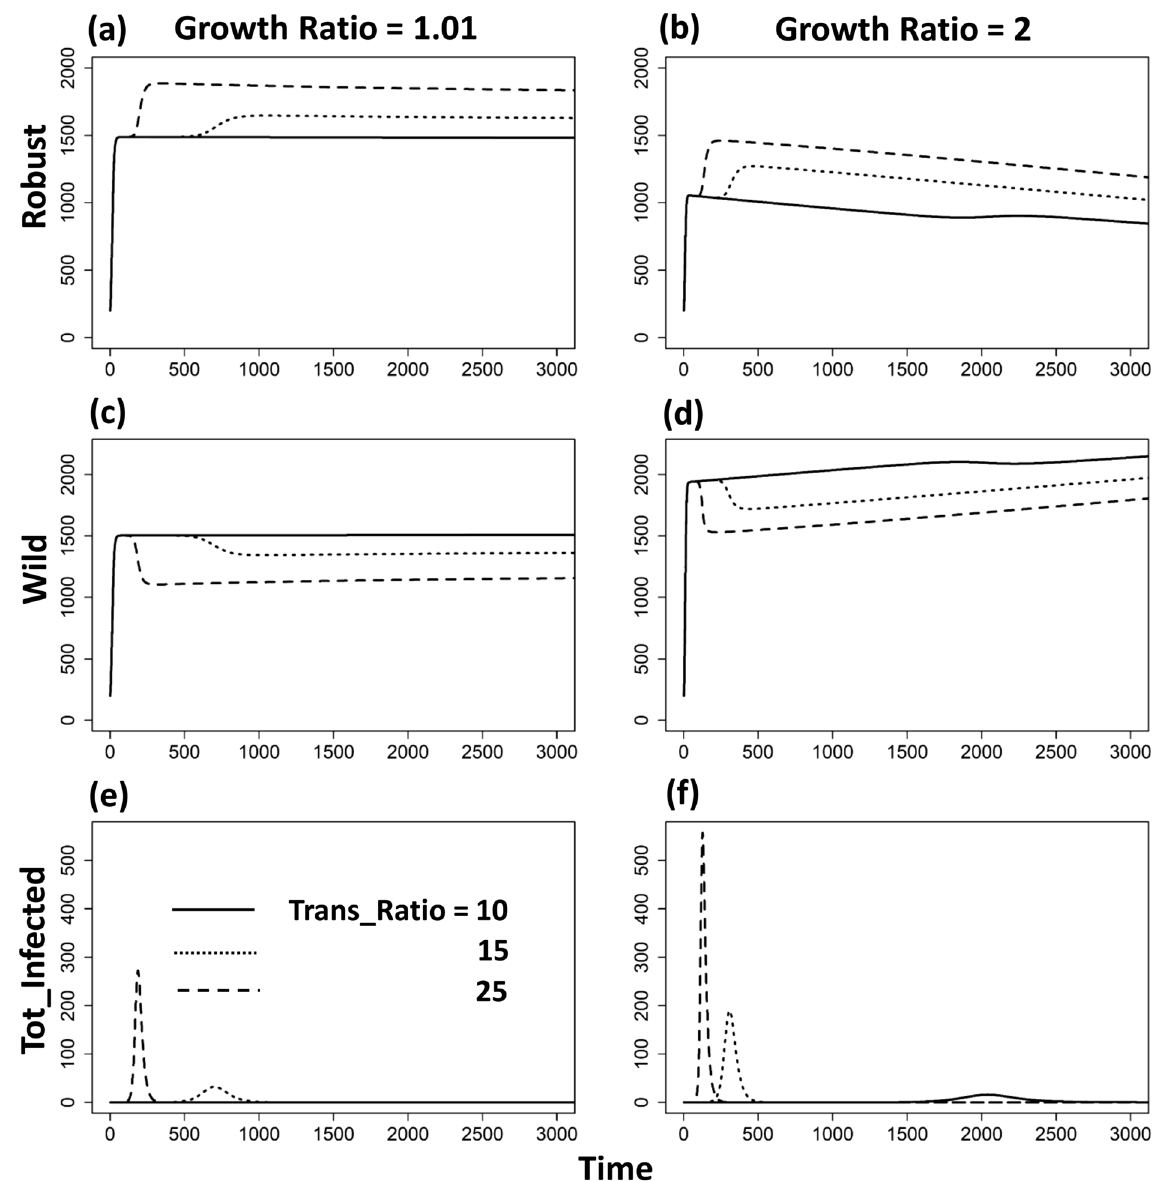
Figure 1. The dynamic changes of two host genotypes (Robust and Wild) and total infecteds under three levels of transmission ratio (10, 15 and 25, indicated by solid, dotted and dashed lines respectively) and two levels of growth ratio (1.01: left panels a , c , e ; 2: right panels b , d , f ) in one isolated patch. The robust type serves as the baseline transmission rate and growth rate of the susceptibles. All the other parameters are: r R = 0.15, r Wd = r Rd = 0.01, r Wr = r Rr = 0.2, α W = α R = 0.05, μ W = μ R = 0.0005, γ W = γ R = 0.05, β RR = β WR = 0.000005. Initial susceptibles of both types are 200, initial infected of both types are 0.0005, and initial recovereds of both types are